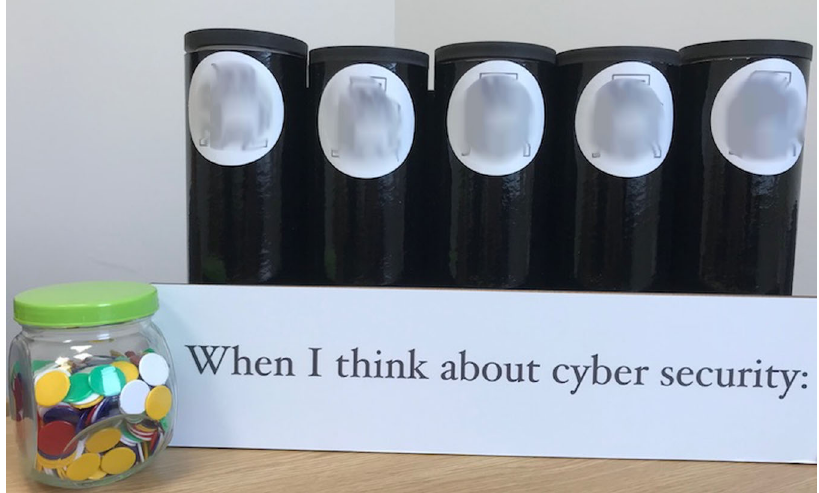
Fig. 3 The EARNEST: affEct RespoNse mEaSurement Tool based on Bradley and Lang (1994), with obfuscated images on cylinders from Morris (1995). People choose a cylinder based on their emotional state and deposit a plastic coin in a slot at the top.